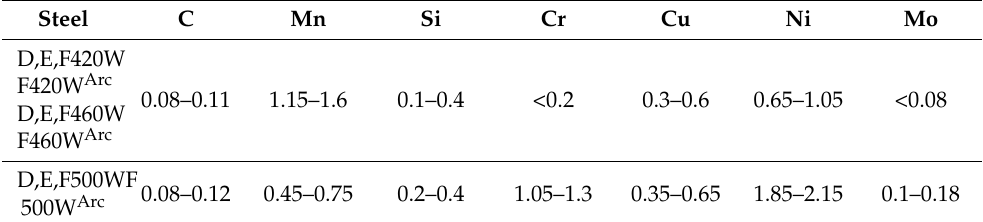
Table 1. Chemical composition of steels according to GOST R 52927-2015, wt%.